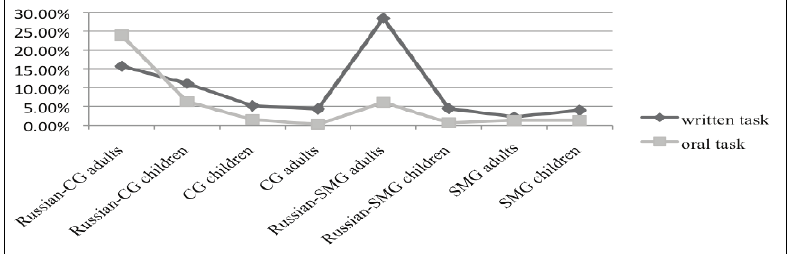
Figure 12: Written vs. Oral task non-target test